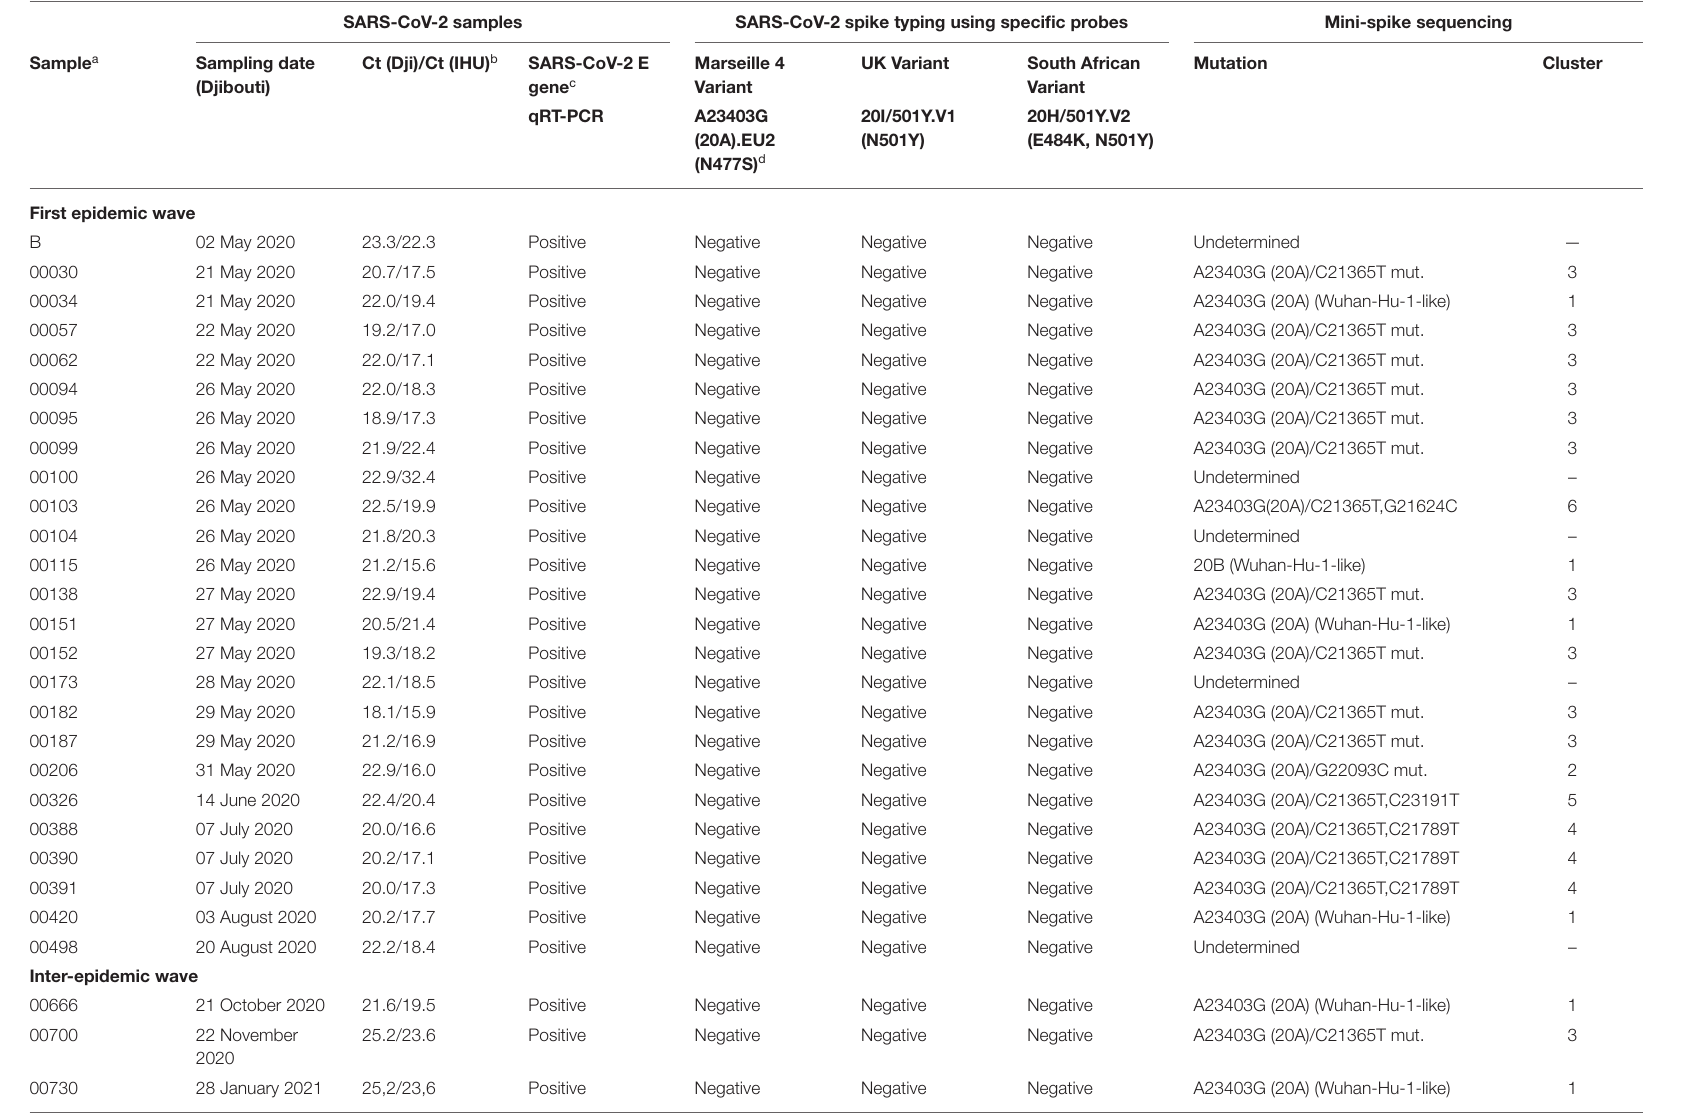
TABLE 1 | Typing of SARS-CoV-2 strains circulating in Djibouti from May 2020 to March